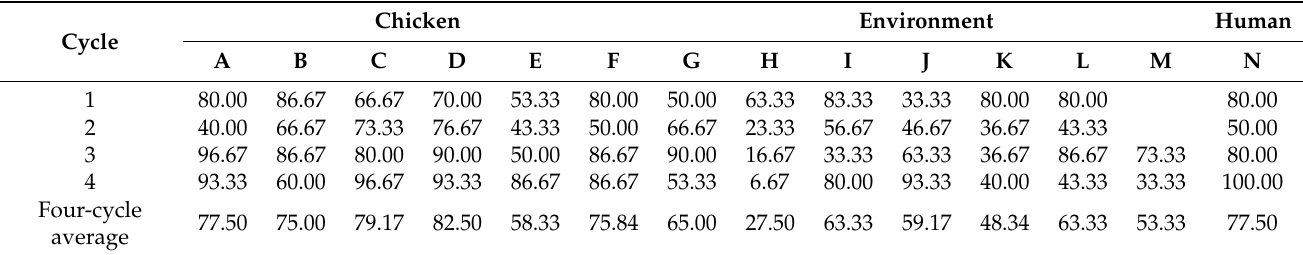
Table 2. Isolation rate of E. coli from different sources in four cycles (unit: %).